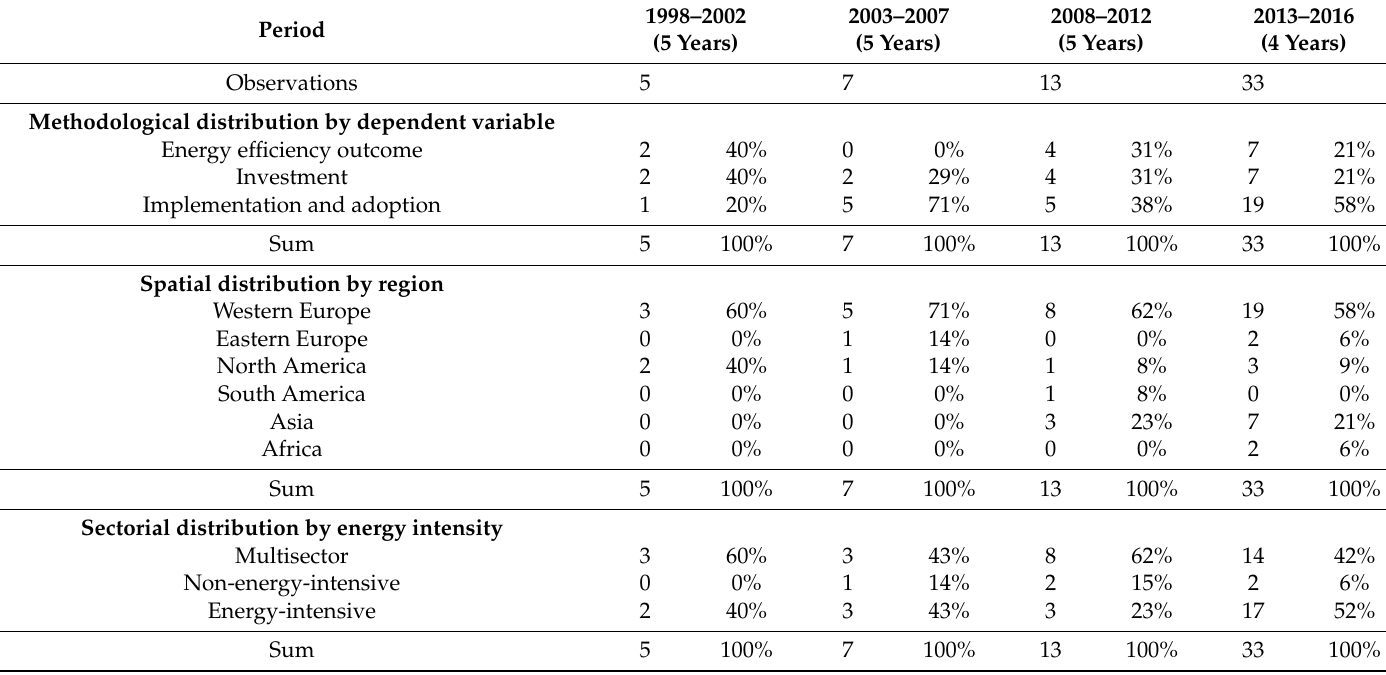
Table A2. Temporal evolvement of the